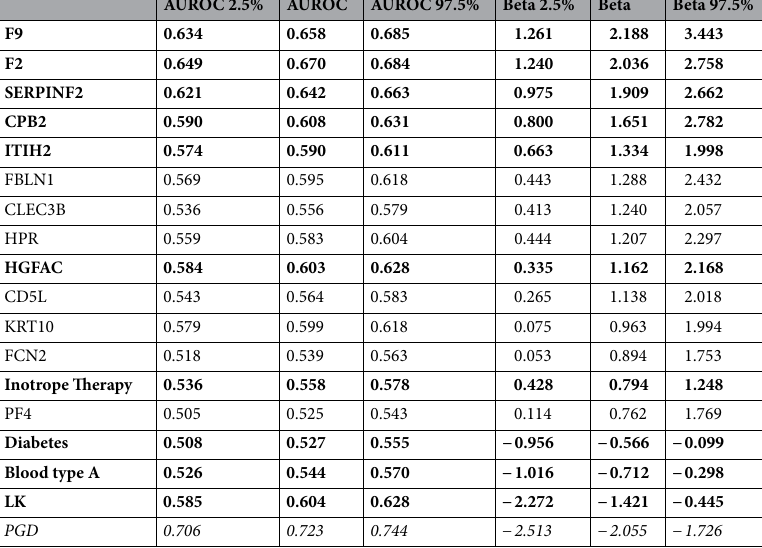
Table 2. Significant markers of post-transplant survival. Bold values significantly predicted post-transplant survival after adjustment for patient site-of-origin. The positive control, PGD, is highlighted in italics. PGD primary graft dysfunction, LMW low molecular